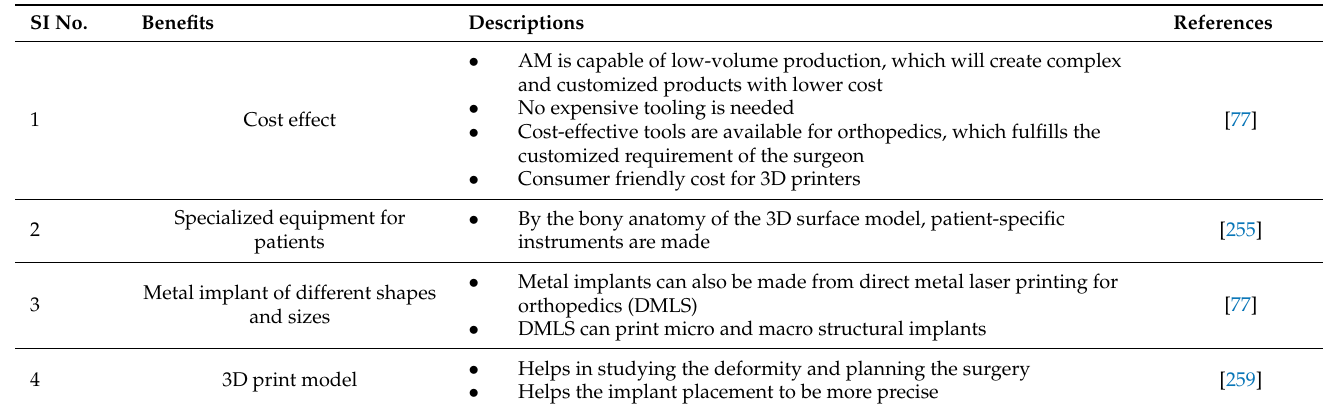
Table 4. Benefits and descriptions of AM in